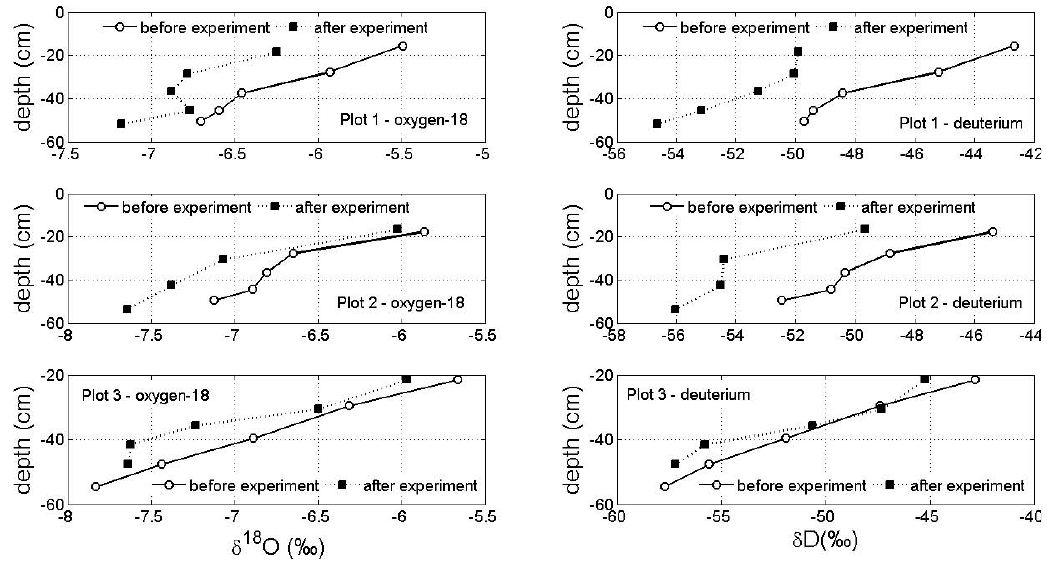
Fig. 3. Measured isotopic composition of soil water, before and after the second experiment at three sampling locations. Left column summarizes oxygen-18 (VSMOW in ‰) and the right column summarizes deuterium (VSMOW in ‰).